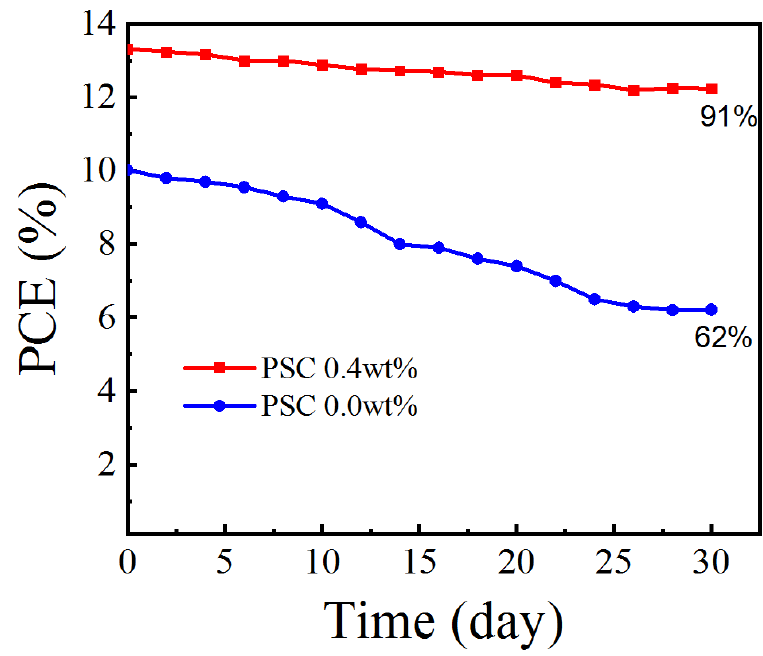
Figure 10. Stability test for the efficiencies of the unpackaged devices based on doped or undoped Spiro-OMeTAD HTLs. Spiro-OMeTAD